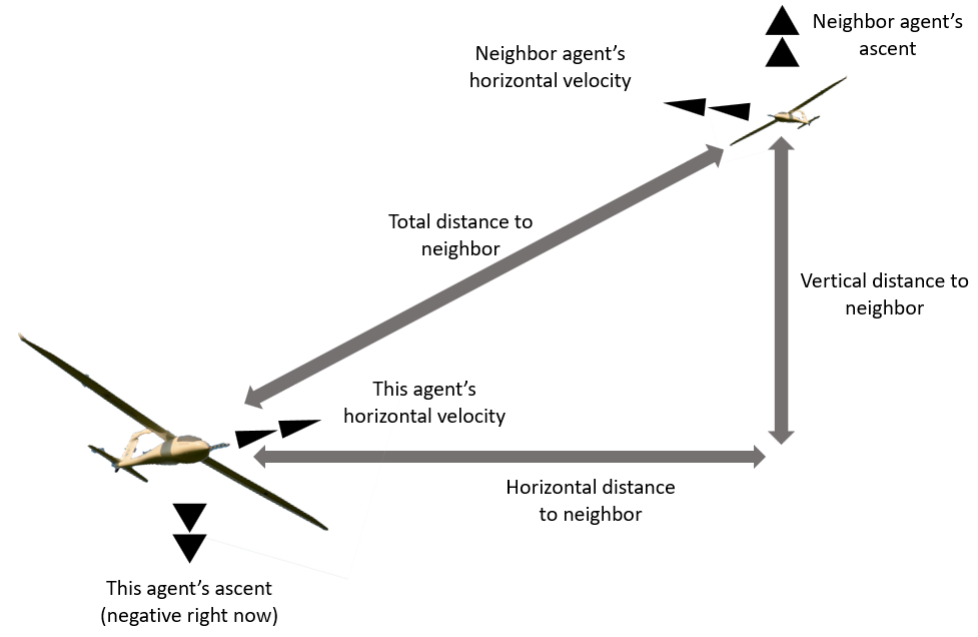
Figure 2. Overview of relevant information between two interacting agents used in calculating agent